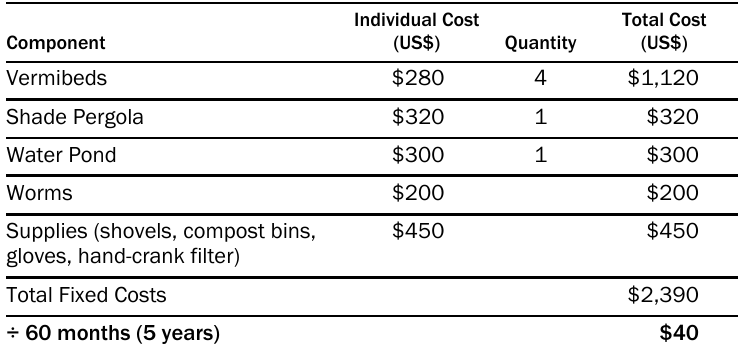
Table B1. Fixed Costs of an Existing